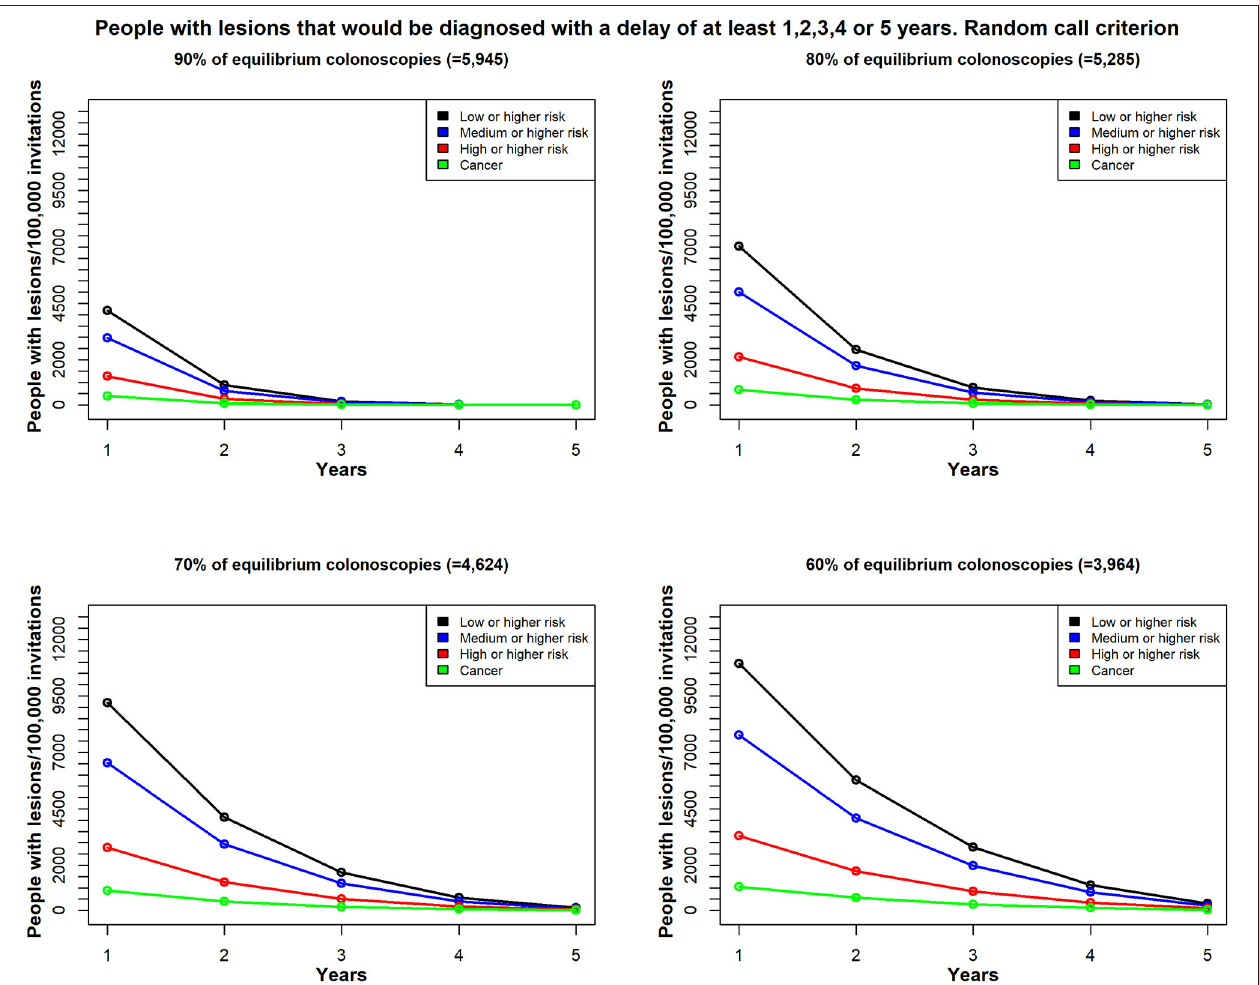
FIGURE 4 | In Scenario 1, the time delay, due to unavailable colonoscopies, for a diagnosis among patients with colorectal lesions in each risk class; patients were re-invited, based on the random call criterion. Total demand for colonoscopies = 6,606/100,000 individuals per year; estimates reflect ( top left ) 90% availability ( n = 5,945); ( top right ) 80% availability ( n = 5,285); ( bottom left ) 70% availability ( n = 4,624); and ( bottom right ) 60% availability ( n = 3,964); Y-axis values reflect the estimated number of patients with lesions that would be diagnosed with a delay of at least 1 year, 2 years up to 5 years; X-axis values reflect the minimum delay